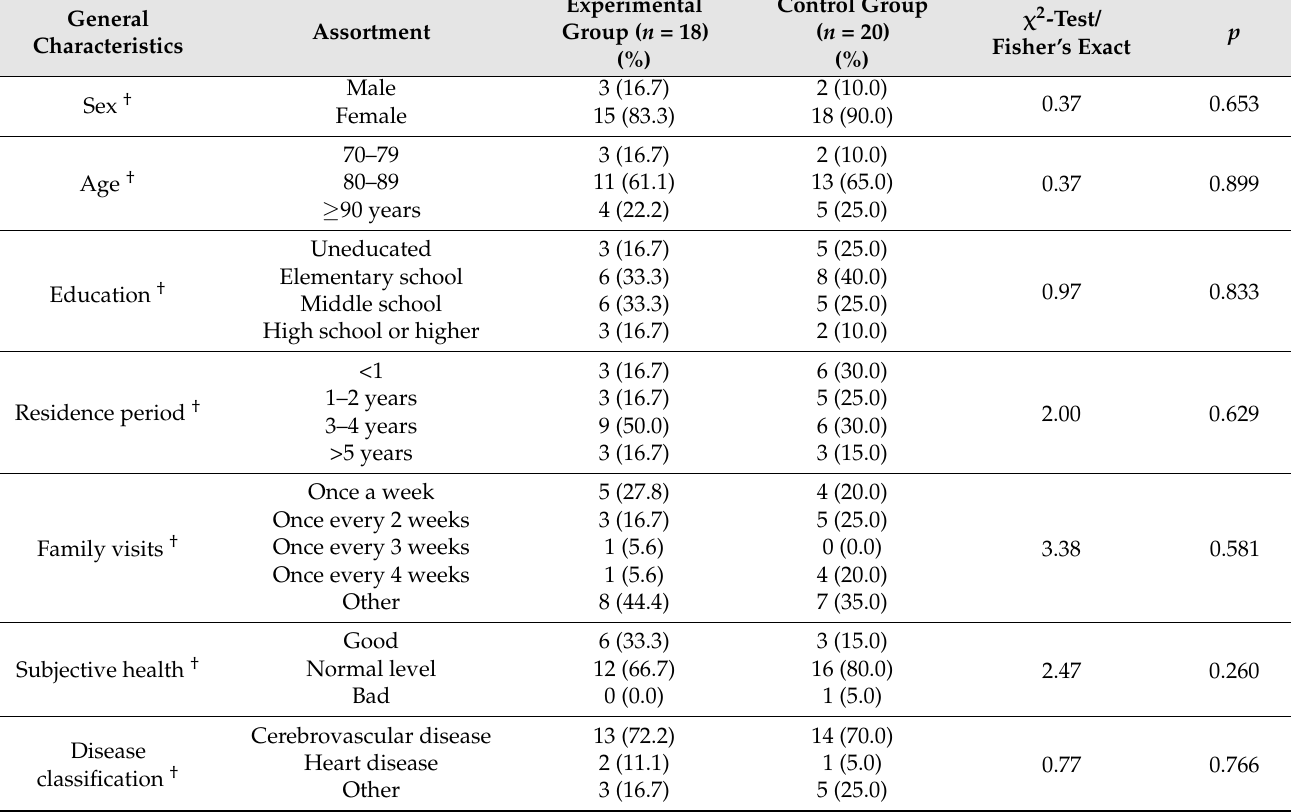
Table 1. Homogeneity Test According to the General Characteristics of the Experimental Group and the Control Group ( n =